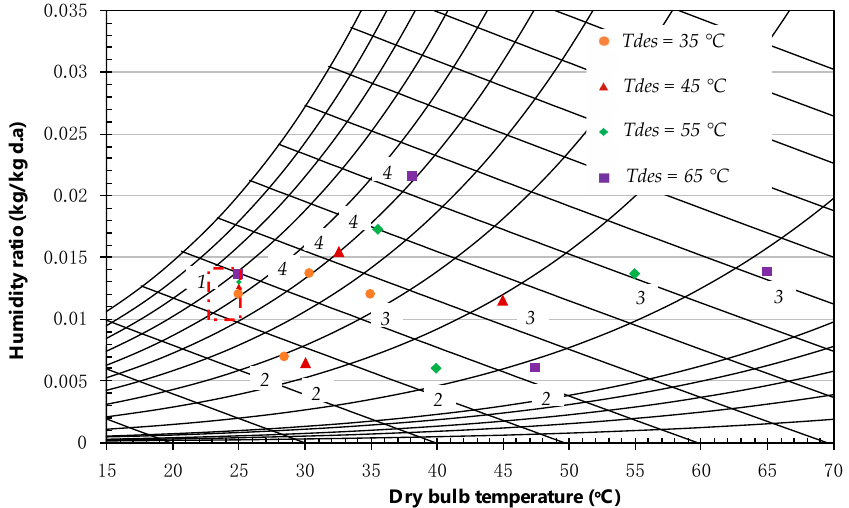
Figure 2. Psychrometric chart of the current experimental point. Tdes: desorption